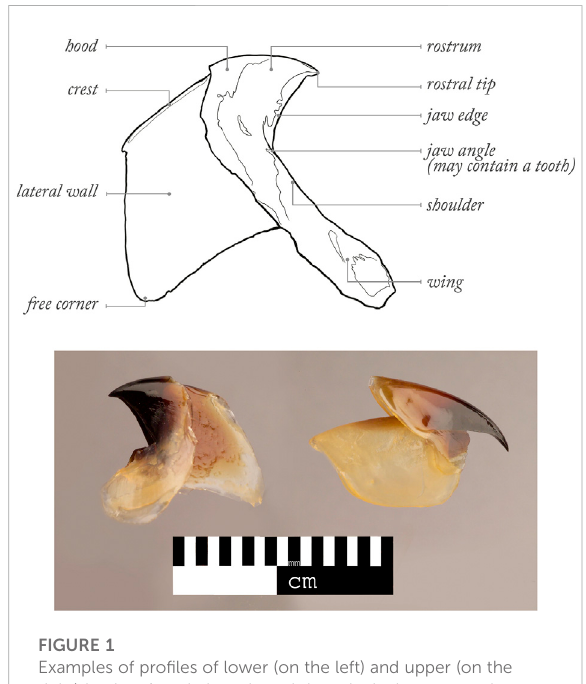
FIGURE 1 Examples of pro fi les of lower (on the left) and upper (on the right) beaks of cephalopods and the principal terms used to characterize decapod beaks (Xavier and Cherel (2021) following Clarke